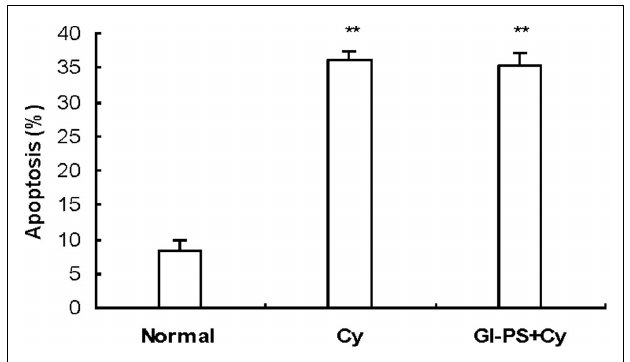
FIGURE 4 | Effect of Gl -PS on apoptosis in BMC in myelosuppressed mice. BMC apoptosis was detected with an AnnexinV-FITC test 24h after i.p., injection of Cy on day 5 during the treatment regime. ** P < 0.01 versus